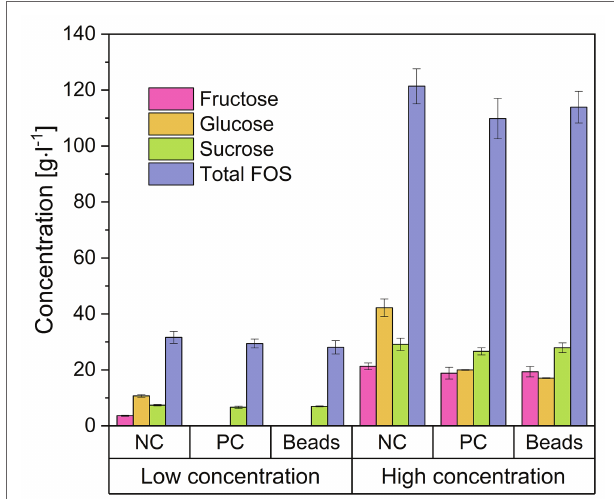
FIGURE 4 | Concentration of the components of a FOS solution mixed with encapsulated Bacillus subtilis . The low and high concentrations refer to FOS solutions containing 20 and 80 g·l −1 of glucose, respectively, which was reduced to 50% by adding an equal volume of alginate beads. Negative control (NC) = 25 ml FOS solution + 25 g cell-free alginate beads. Positive control (PC) = 25 ml FOS solution + 24.5 ml 2 × stock solution of cell free medium + 0.5 ml B. subtilis pre-culture. Beads = 25 ml diluted FOS solution + 25 g alginate beads with immobilized B. subtilis . The concentration was determined after incubation at 40 ° C for 24 h. Values are means ± error ( n =